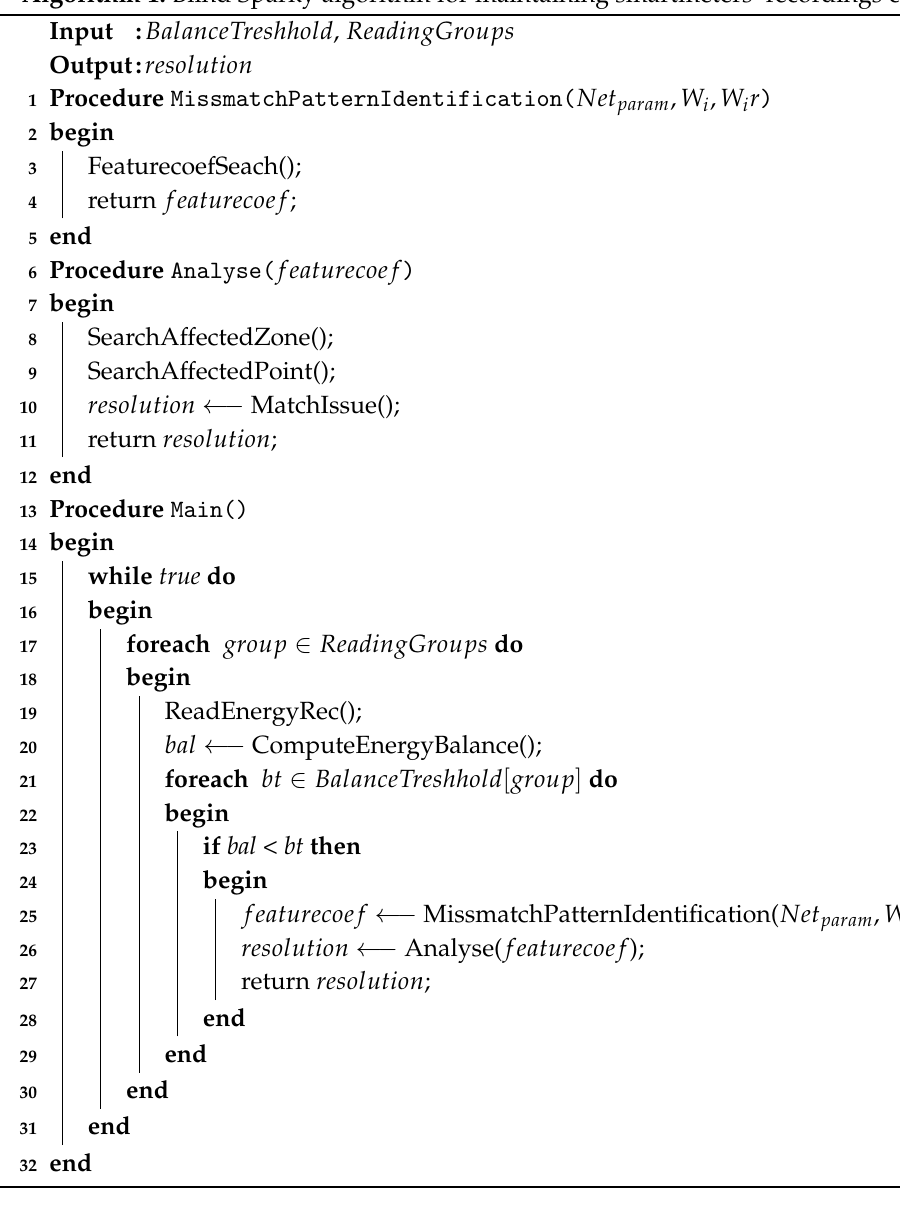
Algorithm 1: Blind Sparky algorithm for maintaining smartmeters’ recordings